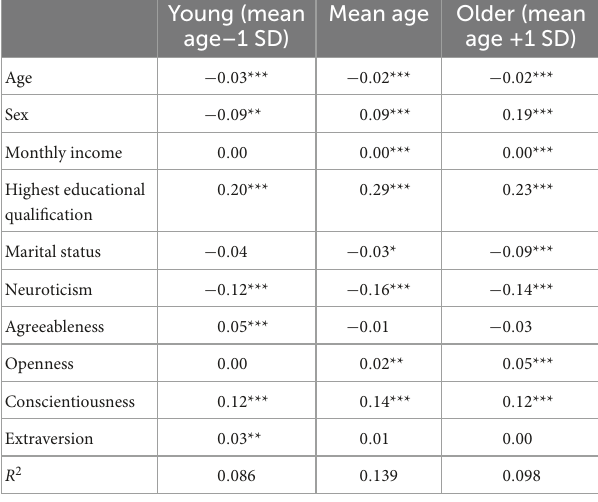
TABLE 4 The regression coefficient ( b ) for demographics and personality traits with the total explained variances ( R 2 ) for young (mean age − 1 SD), mean age, and older people (mean age +1